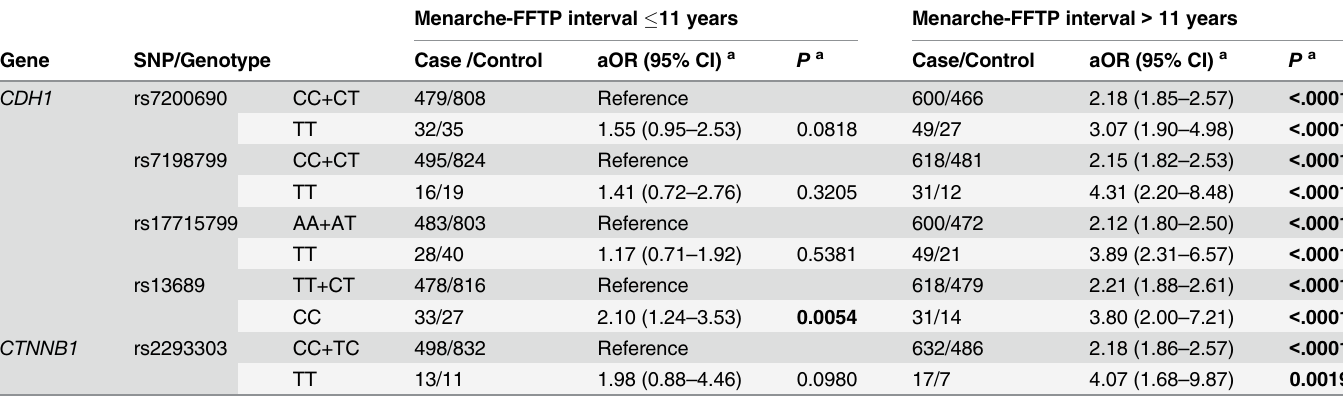
Table 5. Risk of breast cancer associated with the combination of susceptible SNPs and menarche-FFTP interval. Menarche-FFTP interval (cid:1) 11 years Menarche-FFTP interval > 11 years